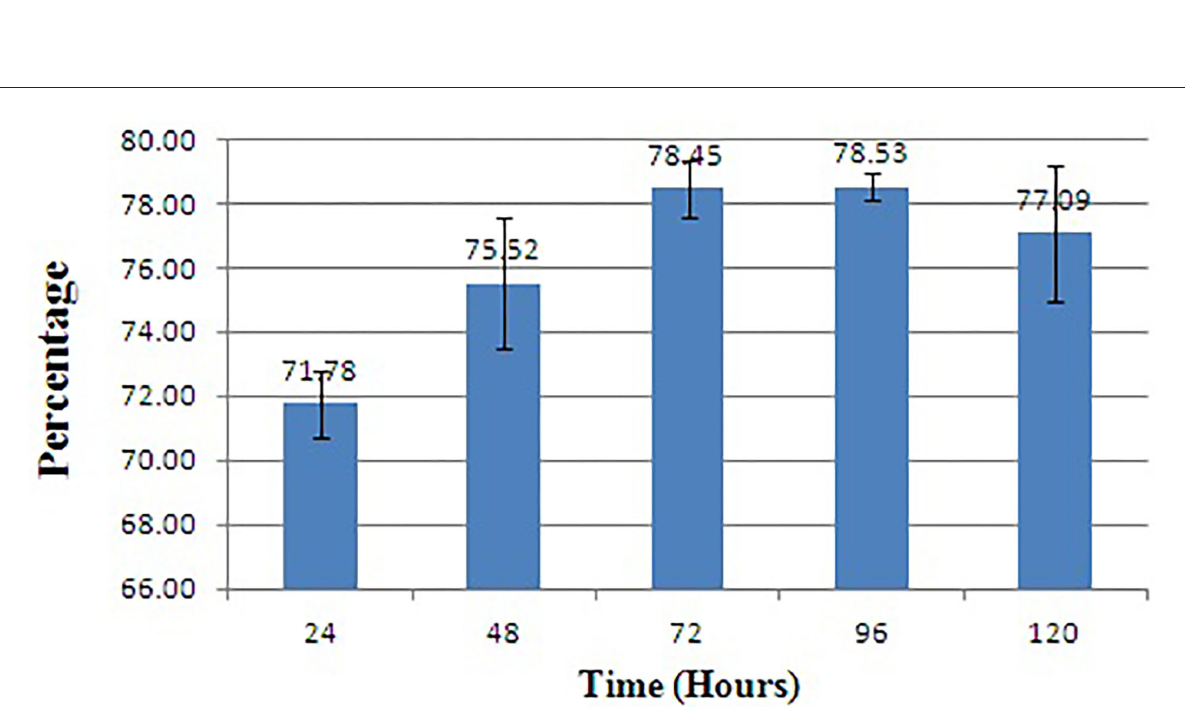
FIGURE7 Biofilm inhibition of L. amnigena RCE. Values represent the mean of three replications. Bars indicate the standard error of the